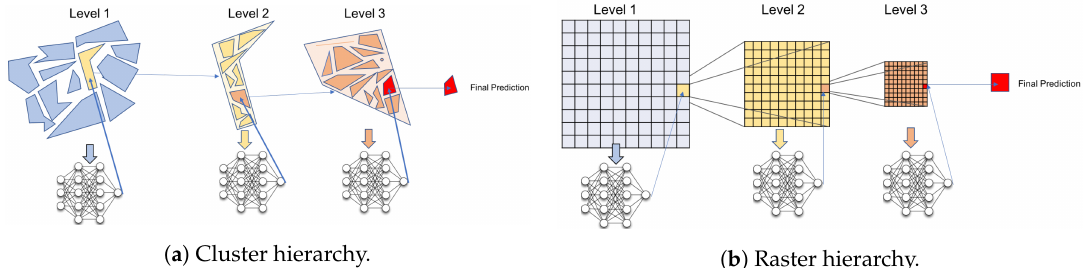
Figure 1. Illustration of both evaluated approaches. On the left, the cluster approach is shown, where a fixed number of clusters is available at each level of the hierarchy. The raster-based approach on the right subdivides each cell into a fixed number of smaller cells based on the smaller cell’s extent. Ultimately, the machine learning model predicts the cluster or raster cell label (represented exemplary by the neural network below each